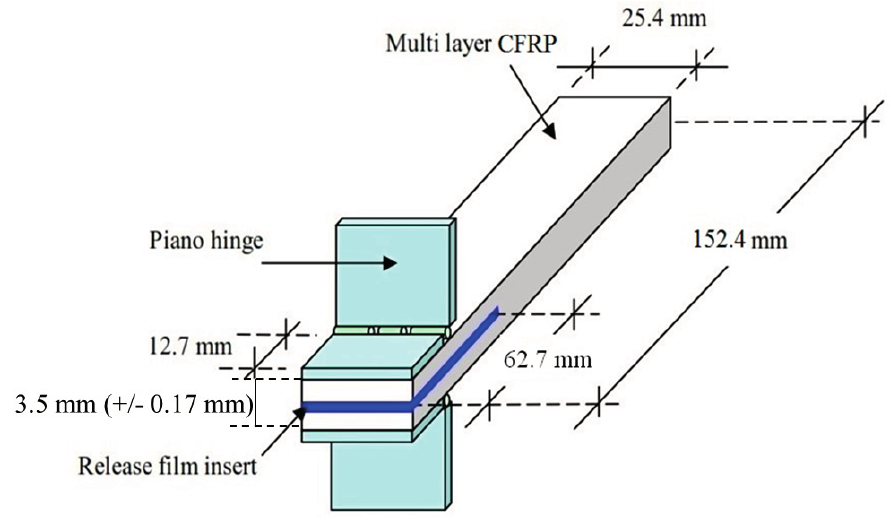
Figure 4. The dimensions of the DCB composite laminate